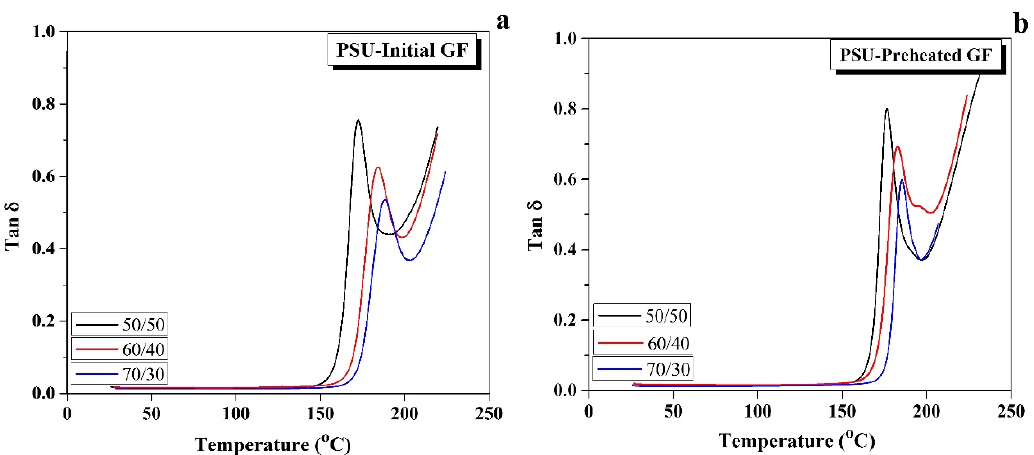
Figure 6. Temperature dependences of Tan δ for the initial ( a ) and ( b ) the preheated GF reinforced composites.